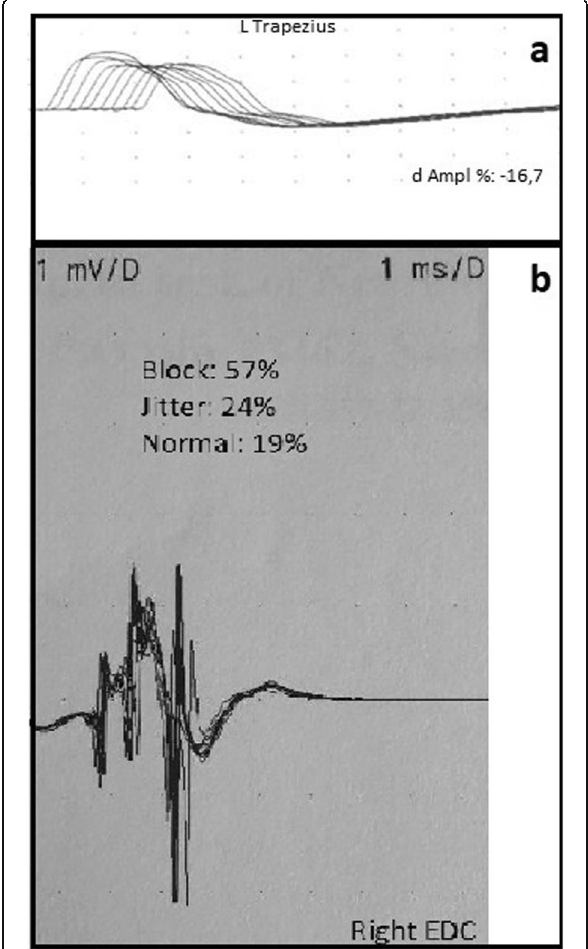
Fig. 1 Left trapezius muscle and right extensor digitorum